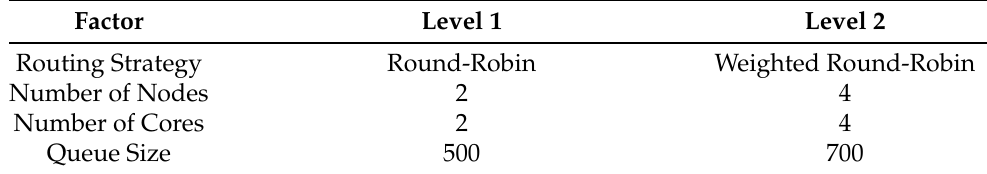
Table 2. DoE factors and levels.